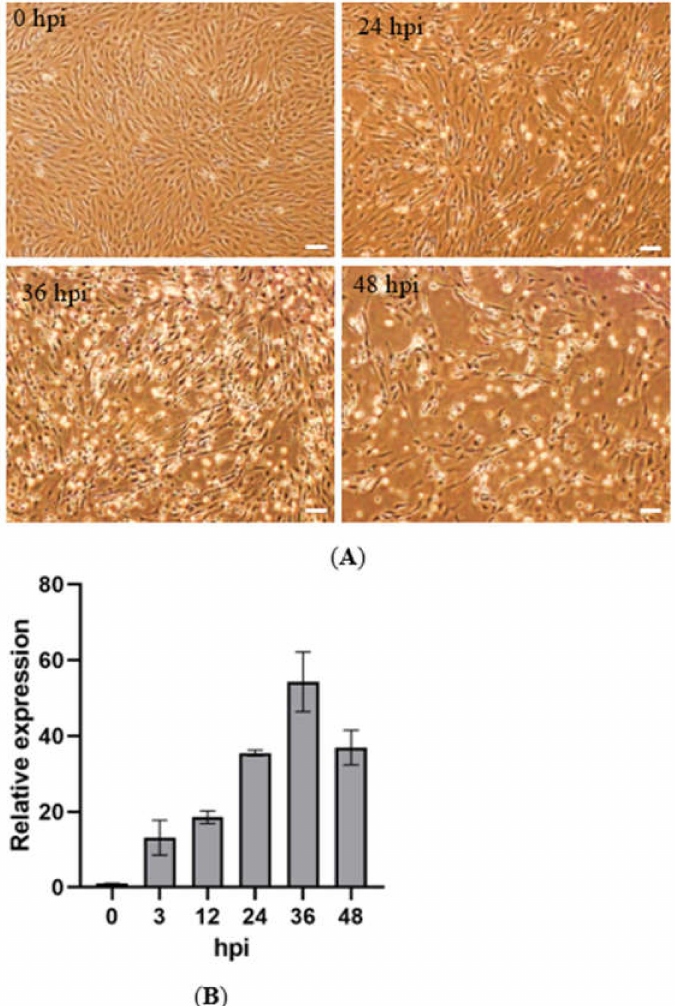
Figure 1. SCRV infection of SCSC cells. ( A ) Microscopy observation of the SCRV infected SCSC cells at different time points. Bar = 100 µ m. ( B ) Relative expression in SCRV infected SCSC cells examined by